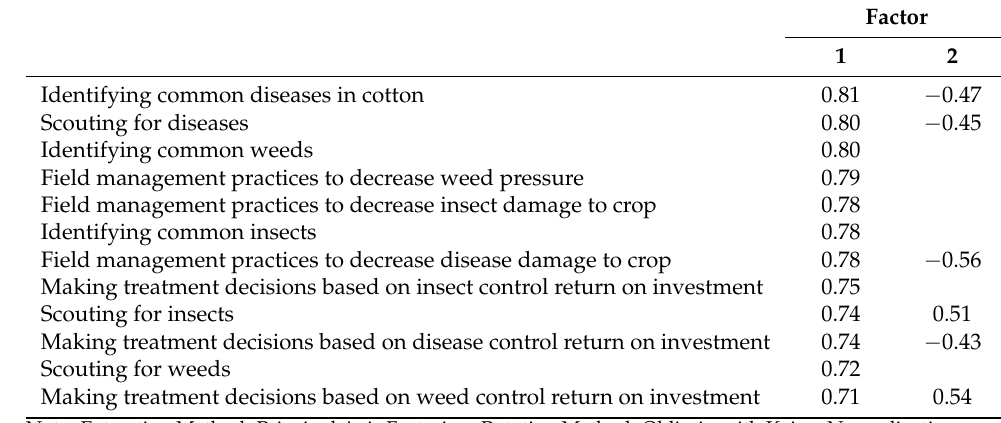
Table 14. Factor loadings and importance items of Integrated Pest Management